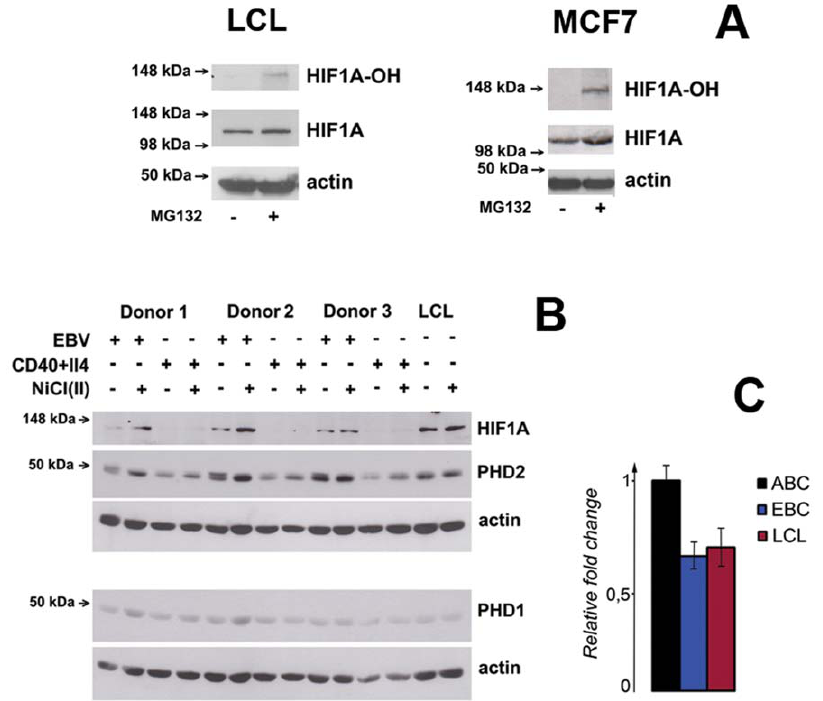
Figure 1. Expression level of HIF1A in EBV-infected and mitogen-activated B-cells, and in LCLs. A – Western blotting of HIF1A and its hydroxylated form in LCLs (left panel). The membrane was probed with mouse antibody against HIF1A and the rabbit serum against the hydroxylated form of HIF1A (HIF1A-OH). Notice the absence of HIF1A-OH in LCLs (first lane) and the lack of effect of proteasome inhibition. In contrast, high levels of hydroxylated HIF1A were detected in control MCF7 cells upon proteasome inhibition (right panel). B – Western blotting of whole cell lysates of CD40 + IL4-activated B-cells, freshly EBV-infected B-cells and LCLs. Cells were treated with 1 mM NiCl 2 , mimicking hypoxia-like conditions. Notice that HIF1A, PHD1 and PHD2 levels in LCLs did not change upon treatment with NiCl 2 , in contrast to freshly infected cells. C – HIF1A expression in CD40 + IL4-activated (ABC), freshly EBV-infected (EBC) B-cells and LCLs (LCL) measured by Q-PCR.